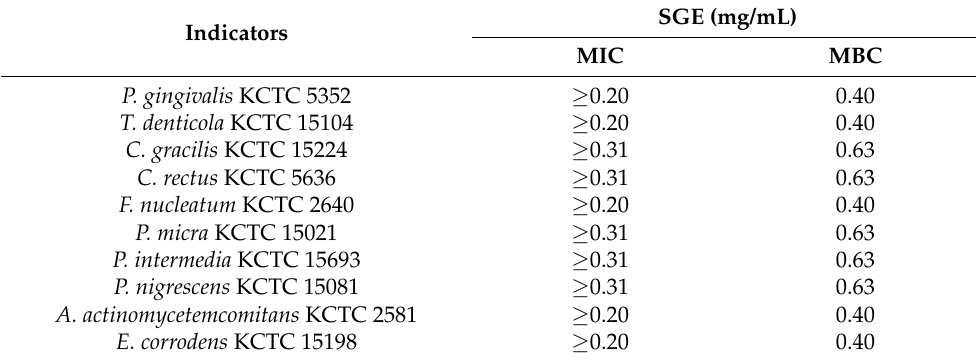
Table 4. MIC and MBC analysis of SGE against periodontal pathogens.